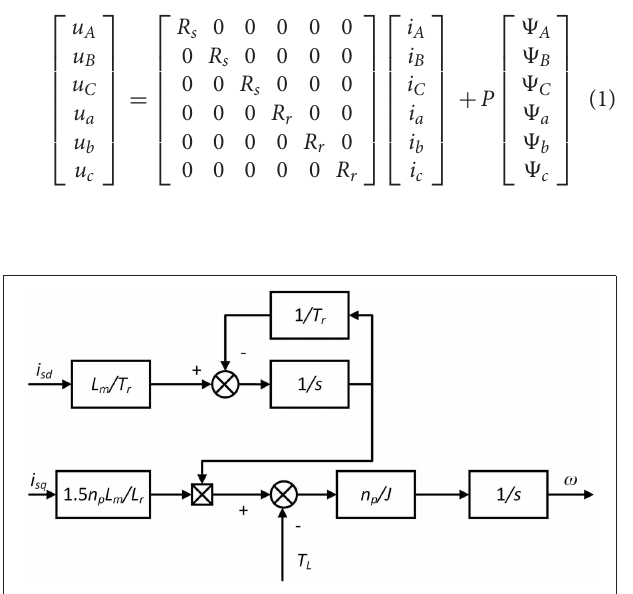
FIGURE 10 | Simplified model of the motor.